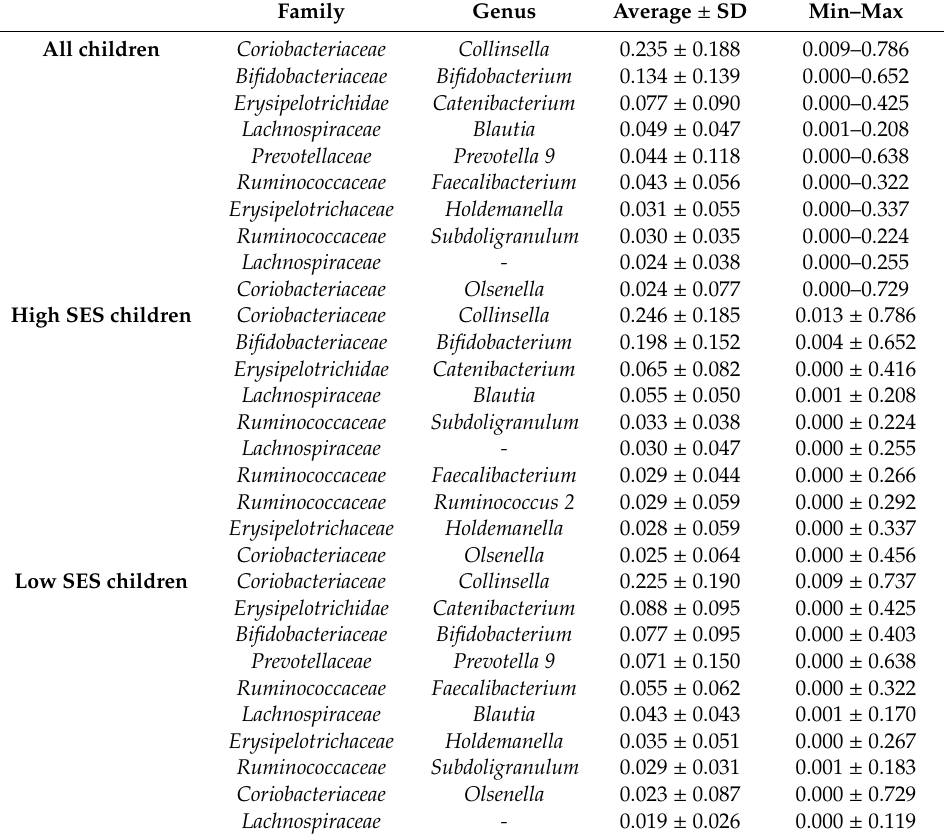
Table 3. The ten most abundant bacterial taxa in all, high SES, and low SES